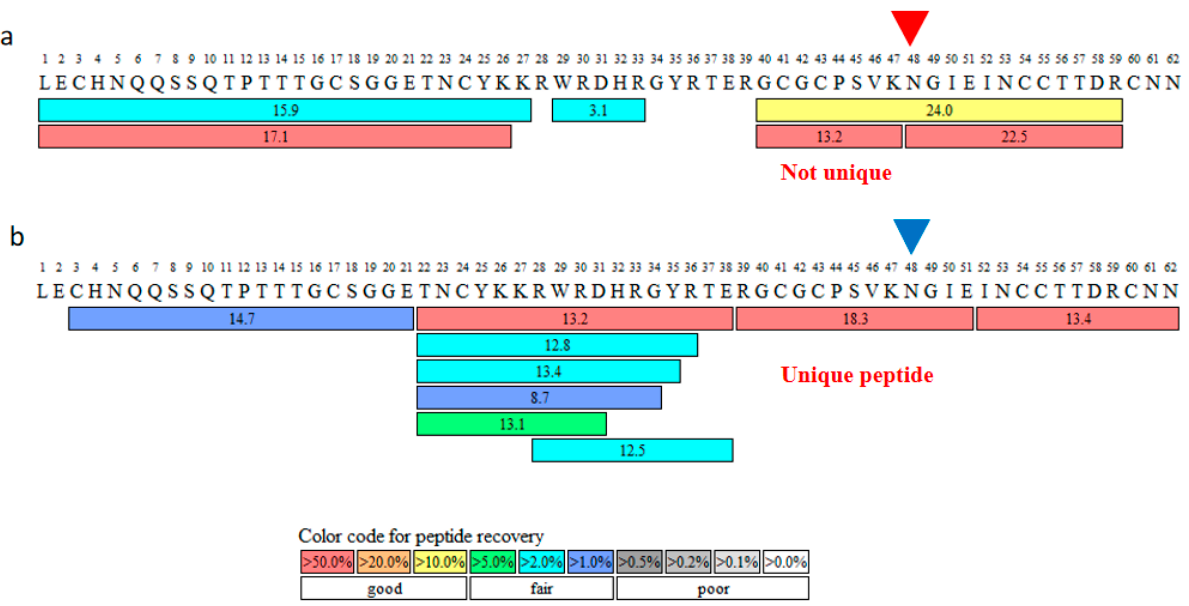
Figure 1. Enzymatic cleavage by ( a ) trypsin and ( b ) Glu-C protease. Enzymatic cleavage with Glu-C protease gives a unique peptide that includes the N48 site. Peptide recovery was calculated using Biopharma Finder software, which defines the concept as the percentage of the total peak area for a given peptide (modified and unmodified forms) relative to the self-weighted average of all components. Thus, a recovery of >10% is considered good recovery.